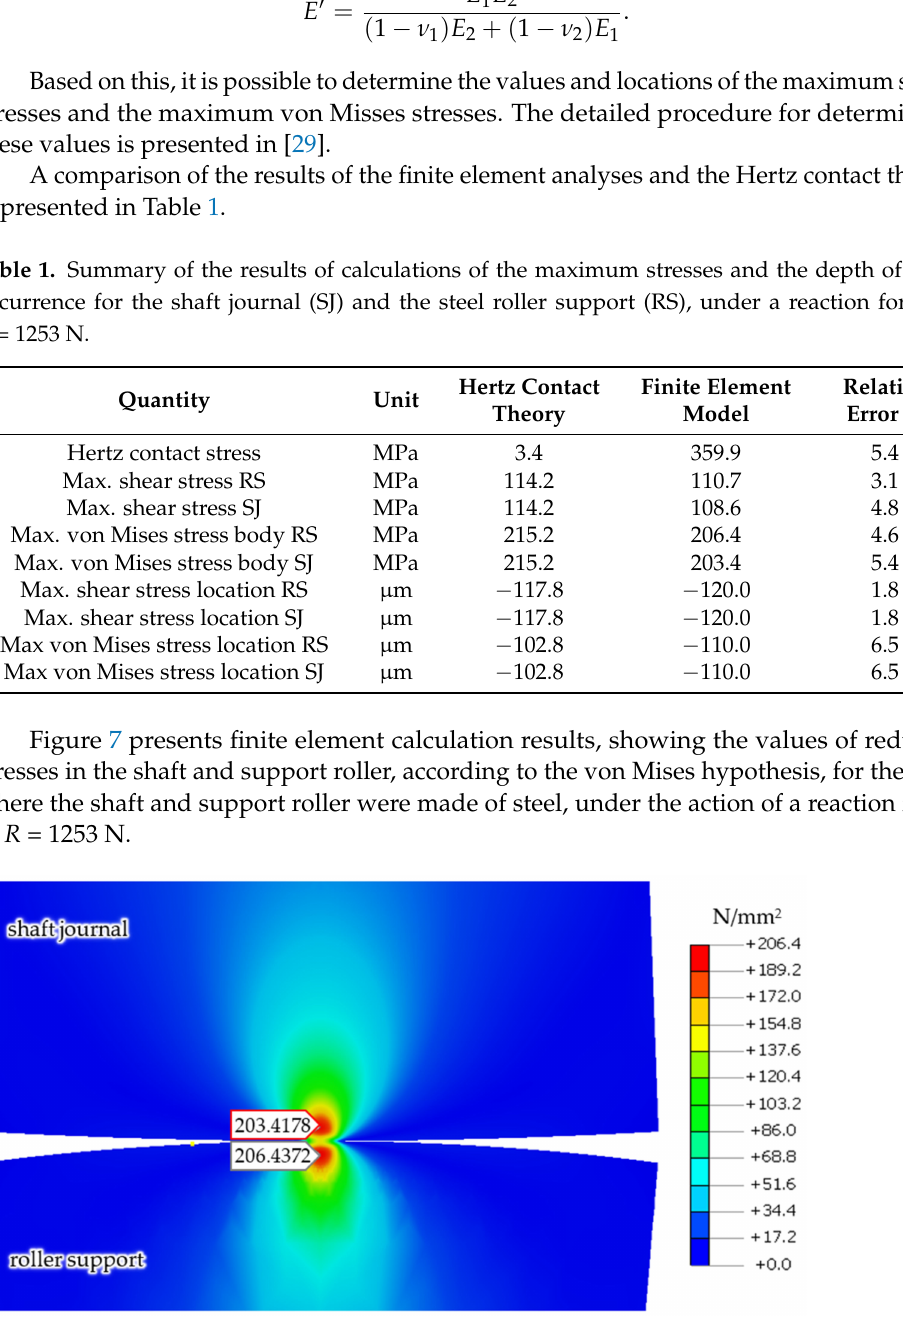
Figure 7. Calculation results of the finite element model, showing reduced stresses in the shaft and support roller, according to the von Mises hypothesis, for the case where a shaft and support roller are made of steel, with a reaction force R = 1253